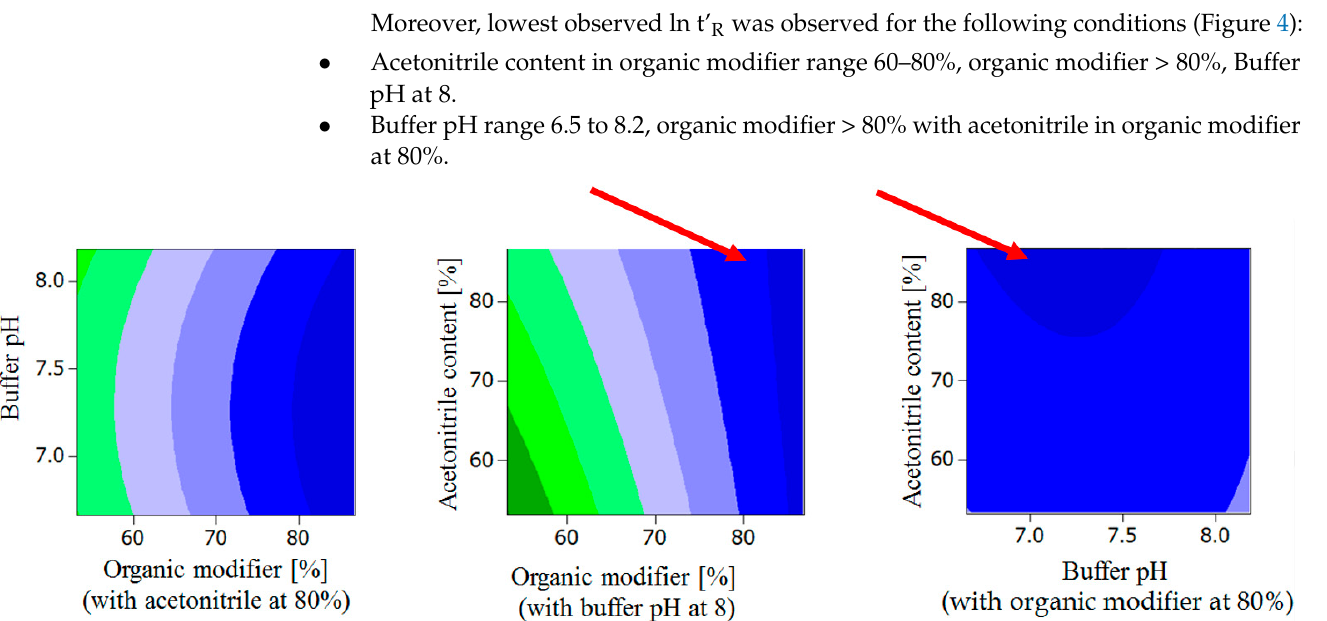
Figure 4. Response surface contour plots for ln t’ R : The dark blue plot regions represent those of the highest ln t’ R . The red arrows indicate the “global solution” predicting the optimum chromato- graphic conditions for lowest t’ R (see Section 2.1.5).